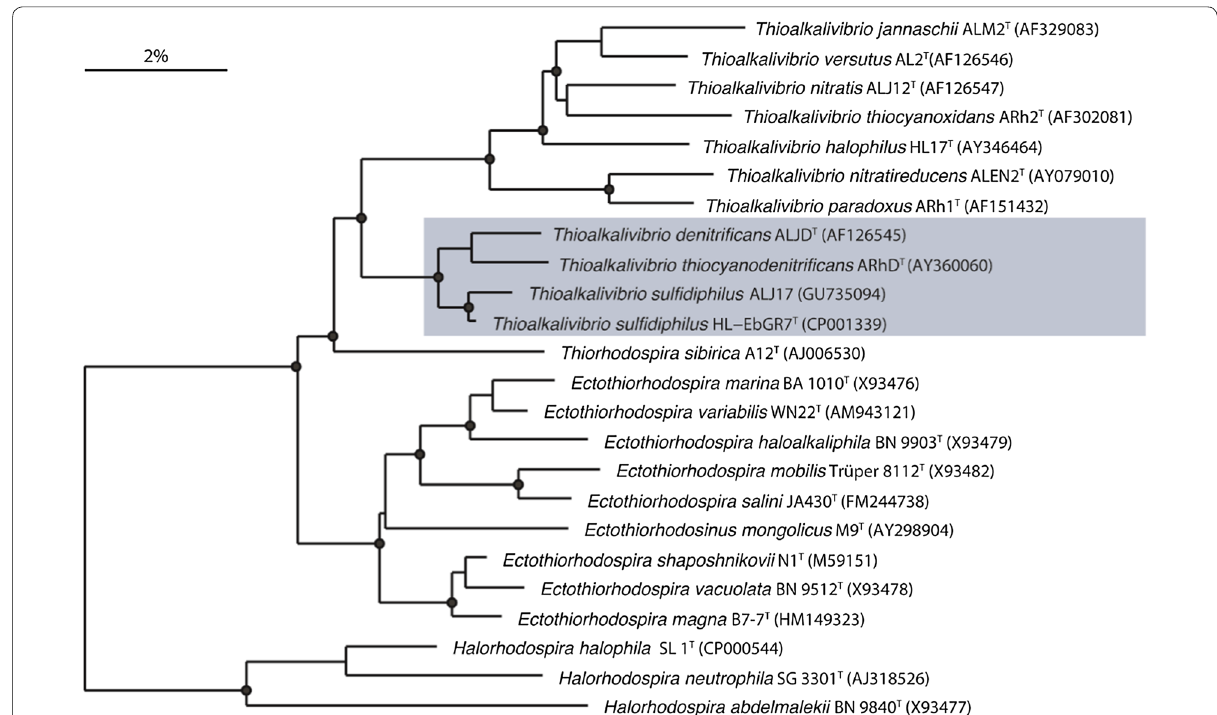
Fig. 1 Phylogenetic position of Thioalkalivibrio sulfidiphilus in the cluster for which primers for Thioalkalivibrio spp. were designed (adapted from Sorokin et al. 2012). Bar indicates 2% sequence